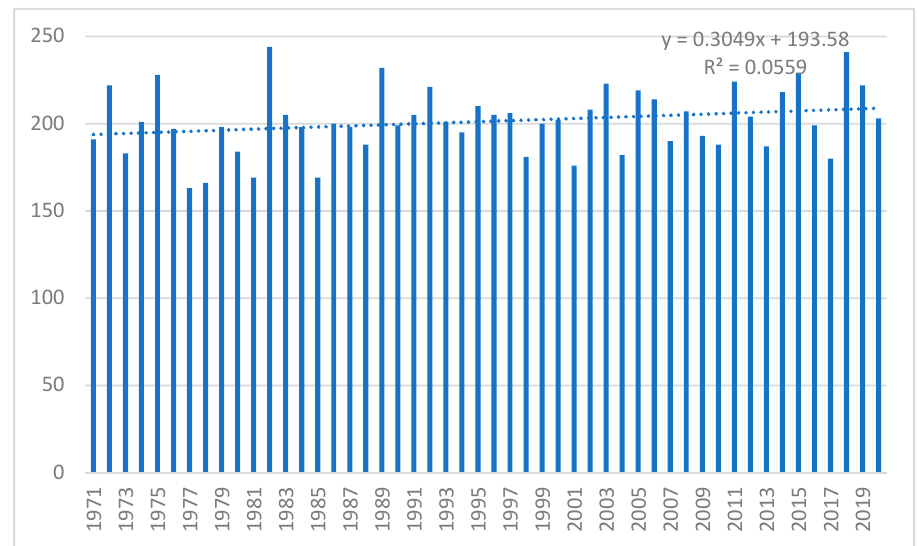
Figure 6. The number of days without any precipitation per year recorded at the meteorological station in Toru ń for the period 1971–2020.